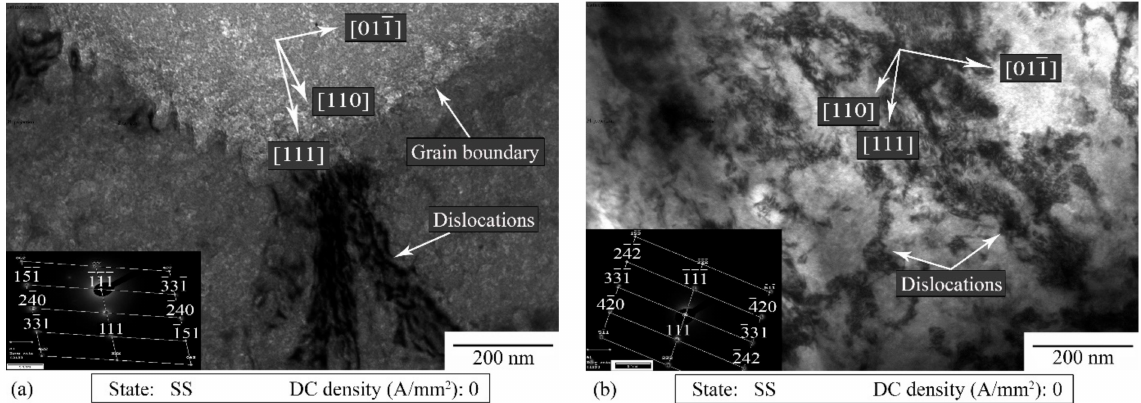
Figure 11. TEM bright-field image of the specimen strained without current to its maximum uniform strain ( a ) and to fracture ( b